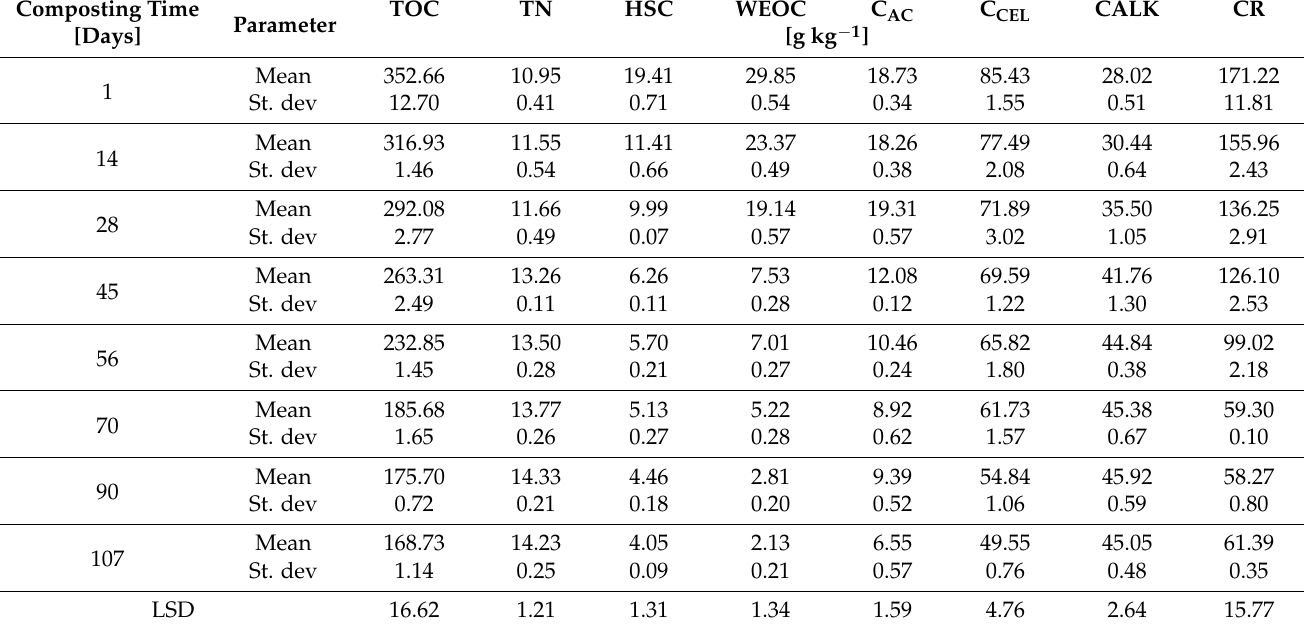
Table 2. Changes in means and standard deviations for the replicates at defined sampling times and LSD ( p < 0.05) for the 90-day period of investigated chemical